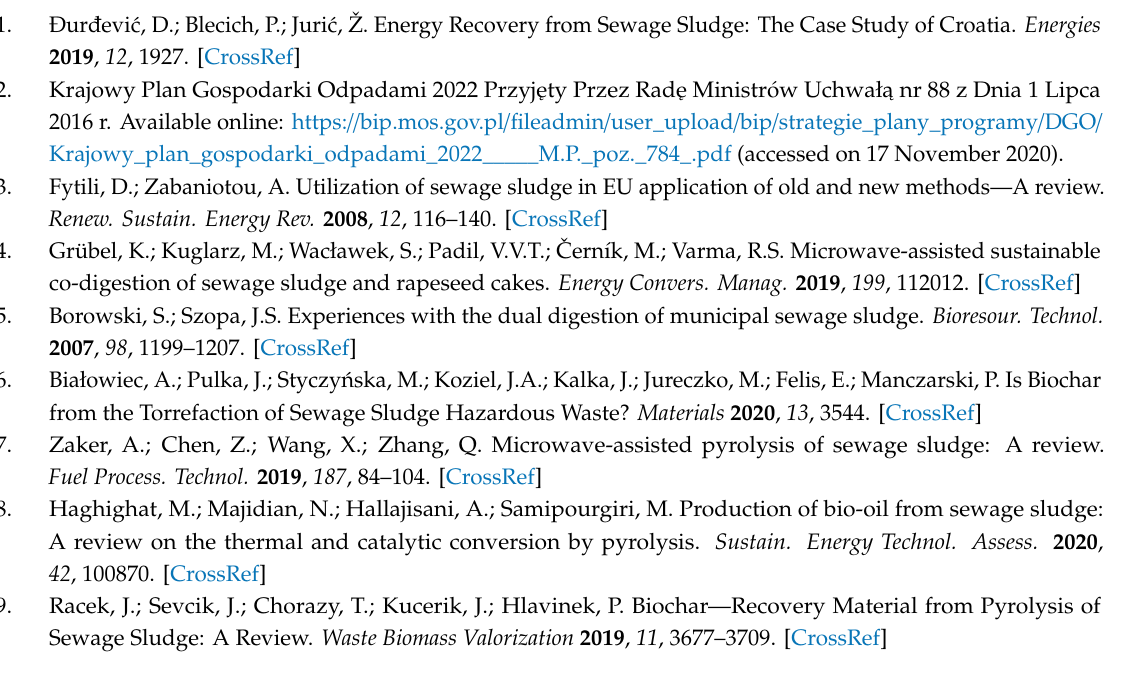
Figure S1: The photograph of (a) rotary tube furnace used in the presented study and (b) automatic screw feeder, Figure S2: The viewfinder in the furnace flange showing the sintered granules during kiln firing, Figure S3: Appearance of (a,b) C 30 SS 50 , (c,d) C 40 SS 40 , and (e,f) C 50 SS 30 aggregates, (a,c,e) before, and (b,d,f) after the crushing resistance tests, Figure S4: The fracture surface of the commercially available Liapor